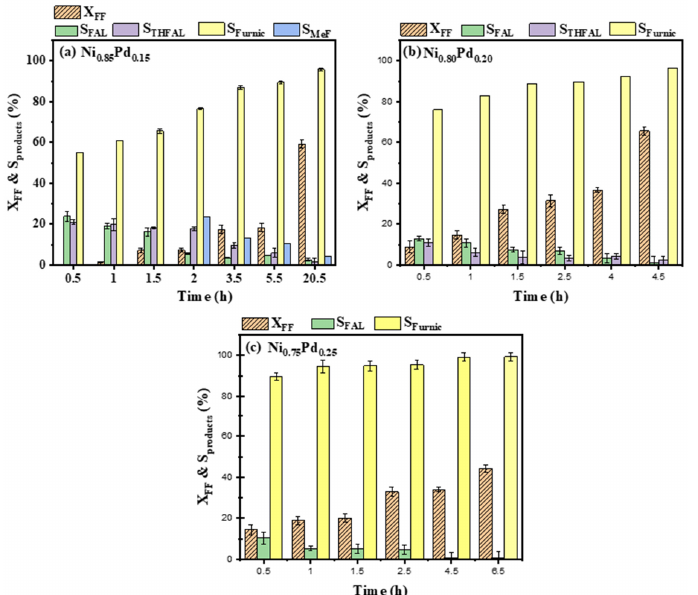
Figure 6. Catalytic performance via furfural conversion (X ff ) and products selectivity (S product ) of ( a ) Ni 0.85 Pd 0.15 , ( b ) Ni 0.80 Pd 0.20 , and ( c ) Ni 0.75 Pd 0.25 for furfural hydrogenation.